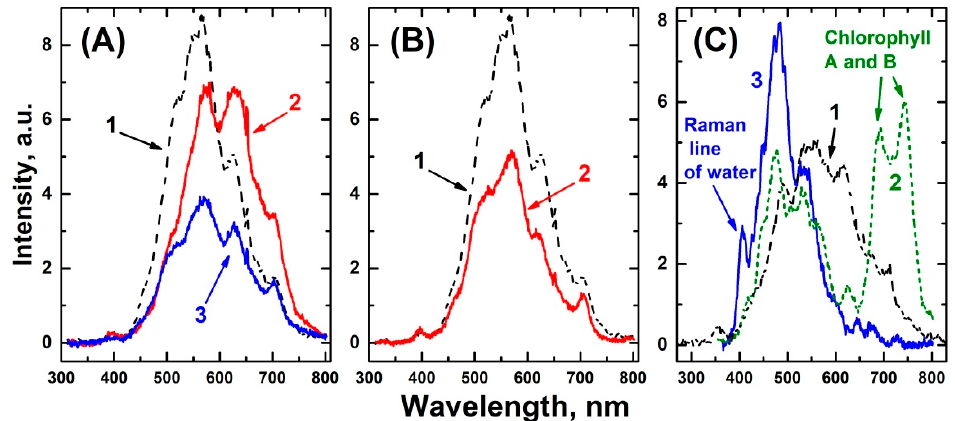
Figure 2. Laser induced fluorescence spectra of soils with the λ = 355 nm excitation. ( A ) soil from various Brazil regions: Amazonas (1) and Rio Grande do Sul (2) States and the Cape Cabo Frio (3). ( B ) Soil samples of Amazonas State from depths 0–6 (1) and 92–134 cm (2). ( C ) Upper soil of Mato Grosso do Sul State (1), leaf of Brazilian acacia Pao Brasil (2) and seawater of coastal area near Leme beach, Copacabana, city of Rio de Janeiro (3). Spectrum (3) exhibits known fluorescence peaks of chlorophylls A and B, seen also in (2), as well as the Raman peak of